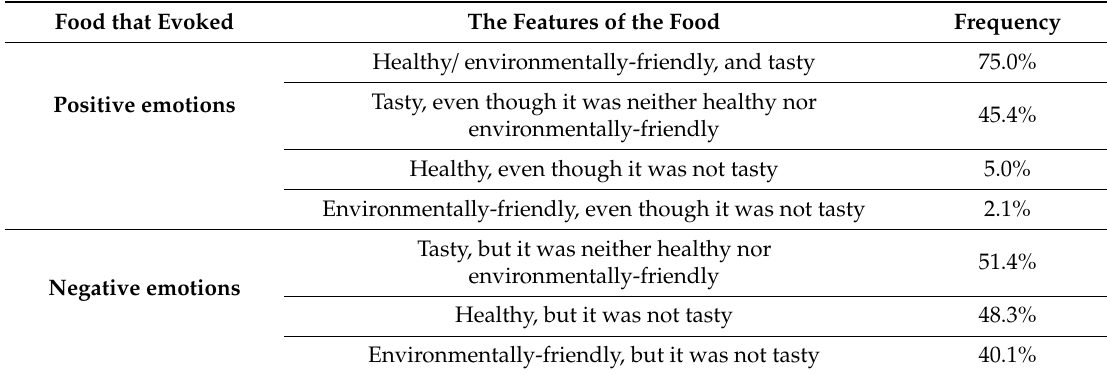
Table 2. The characteristics of the food that evoked positive or negative emotions in the imagined consumption